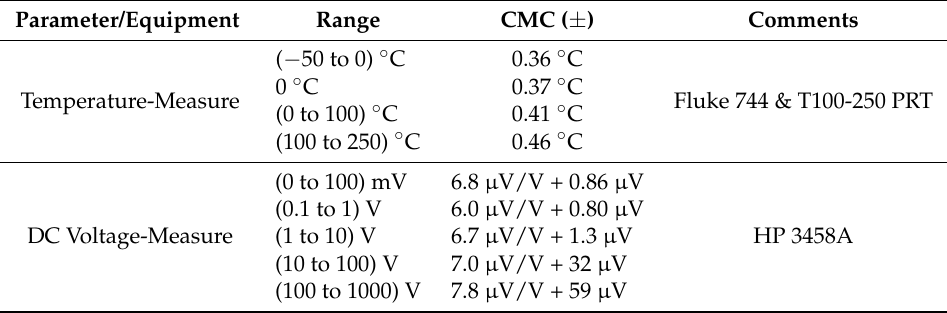
Table 1. An excerpt from an SoA certificate showing CL scope for two different parameters. Parameter/Equipment